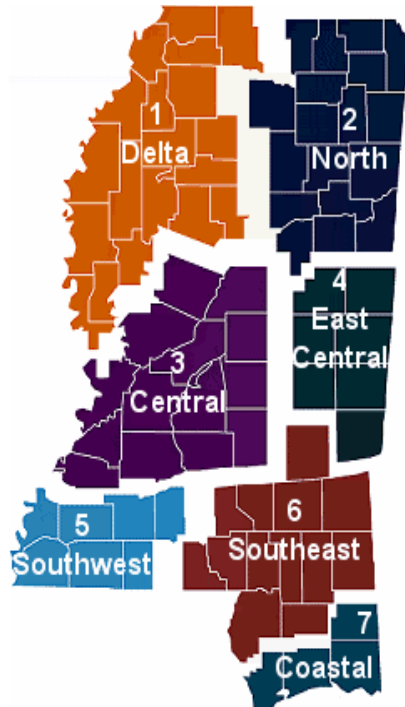
Figure 1: Mississippi Trauma Care System – Trauma Care